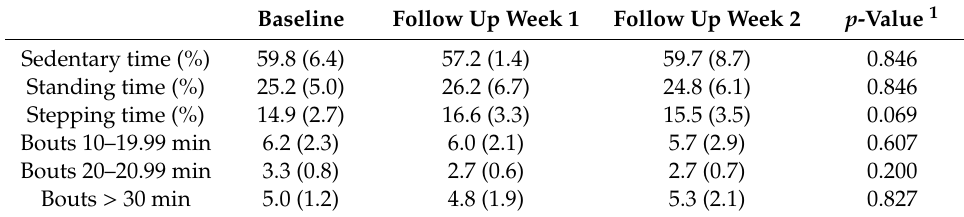
Table 3. Intervention outcomes for the whole day (mean ± SD; n = 6).